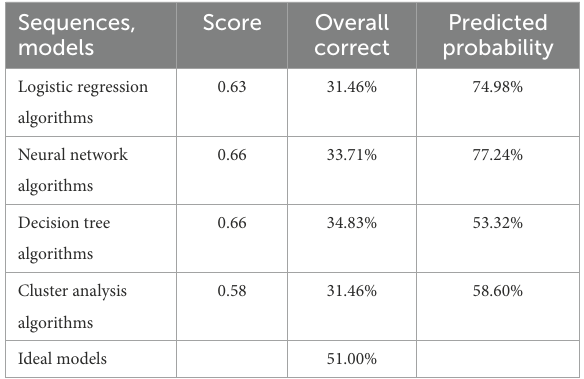
TABLE 1 Comparison of different